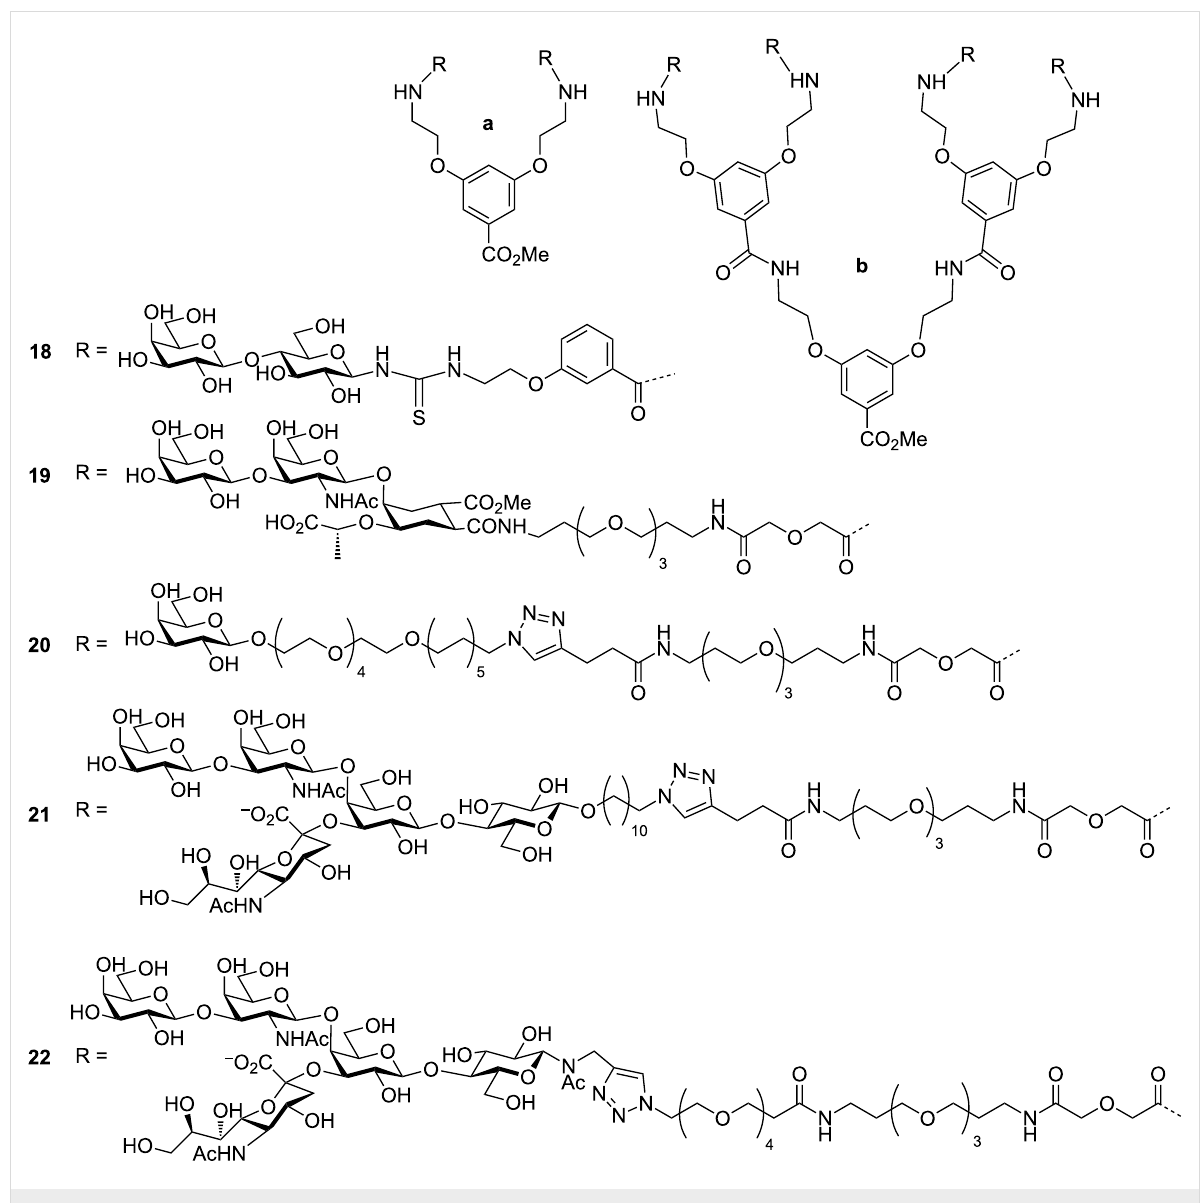
Figure 8: Bivalent and tetravalent inhibitor designed and synthesised by Pieters, and Bernardi et al.